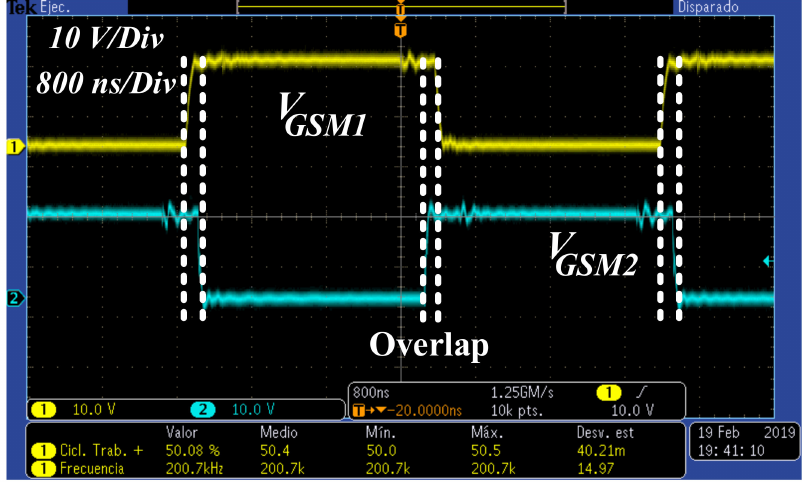
Figure 12. Overlapping signals performed for the second array.